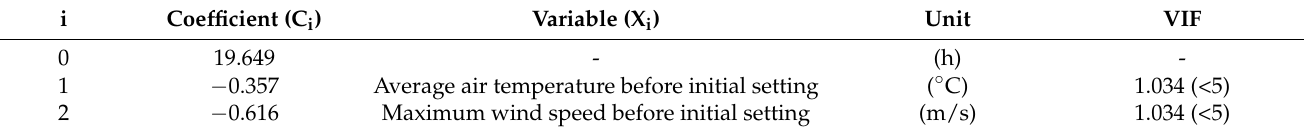
Table 8. Prediction equation of initial setting time of concrete under storehouse surface environment (R 2 =